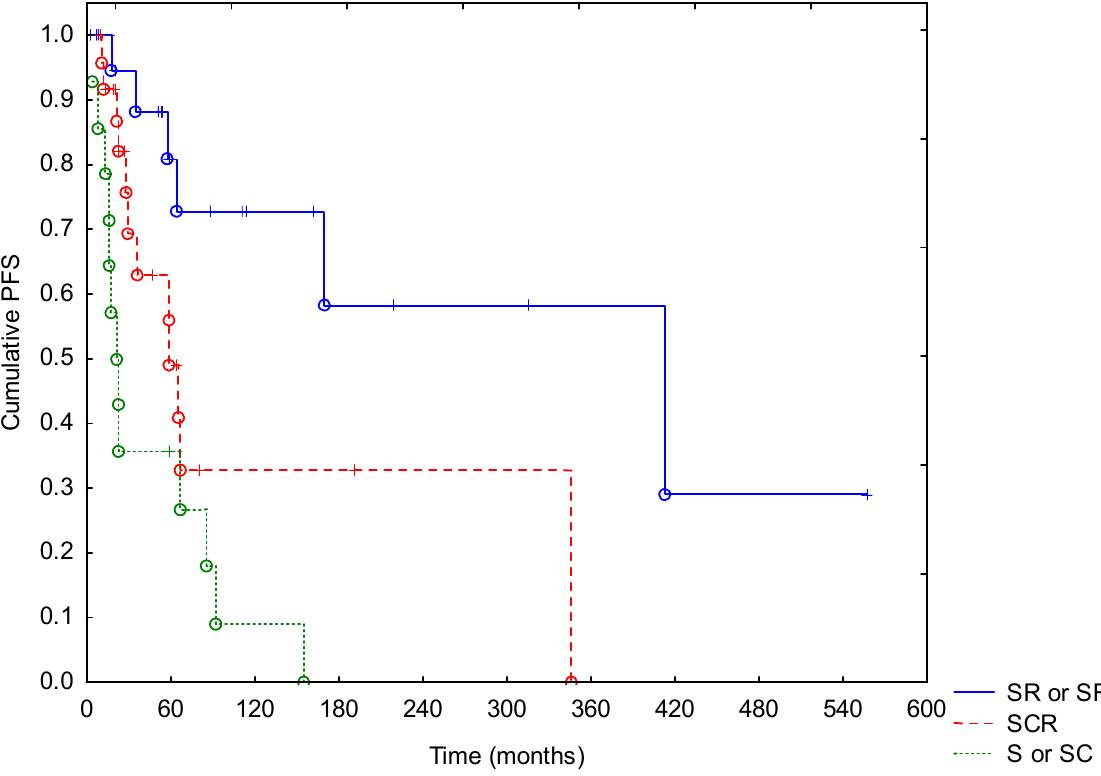
Figure 3. Progression-free survival (PFS) based on the sequence of primary treatment applied in brain tumour patients without metastases (SRC—surgery + RTH + CTH; SR—surgery + RTH; SCR—surgery + CTH + RTH; S—surgery; SC—surgery + CTH). Abbreviations: CTH—chemotherapy; RTH—radiotherapy.